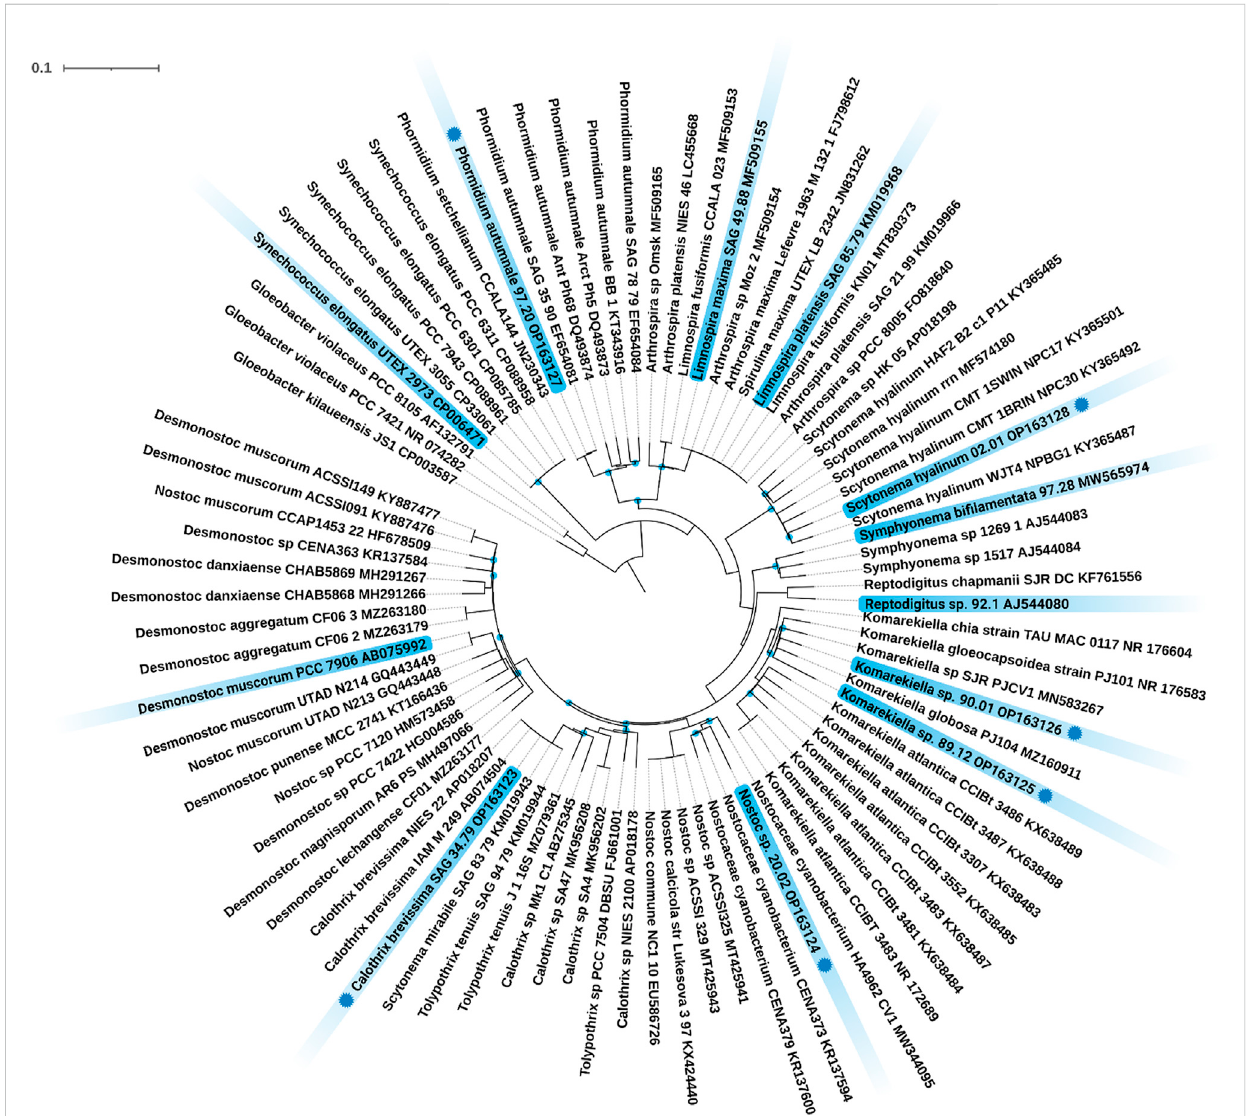
FIGURE 1 Maximum Likelihood (ML) phylogenetic tree based on the 16S rRNA gene region. Marked in blue are the twelve investigated strains including their strain number and NCBI accession number. Strains with a blue dot indicate novel 16S rRNA sequences generated during this study. Since the resulting Bayesian Inference (BI) and ML phylogenetic trees mostly showed the same topology, a single tree with both BI and ML bootstrap values is shown. Supports at the nodes greater than 90% statistical support from BI and ML represent posterior probabilities, and bootstrap values indicated as blue circles. The scale bar speci fi es 0.1 expected changes per